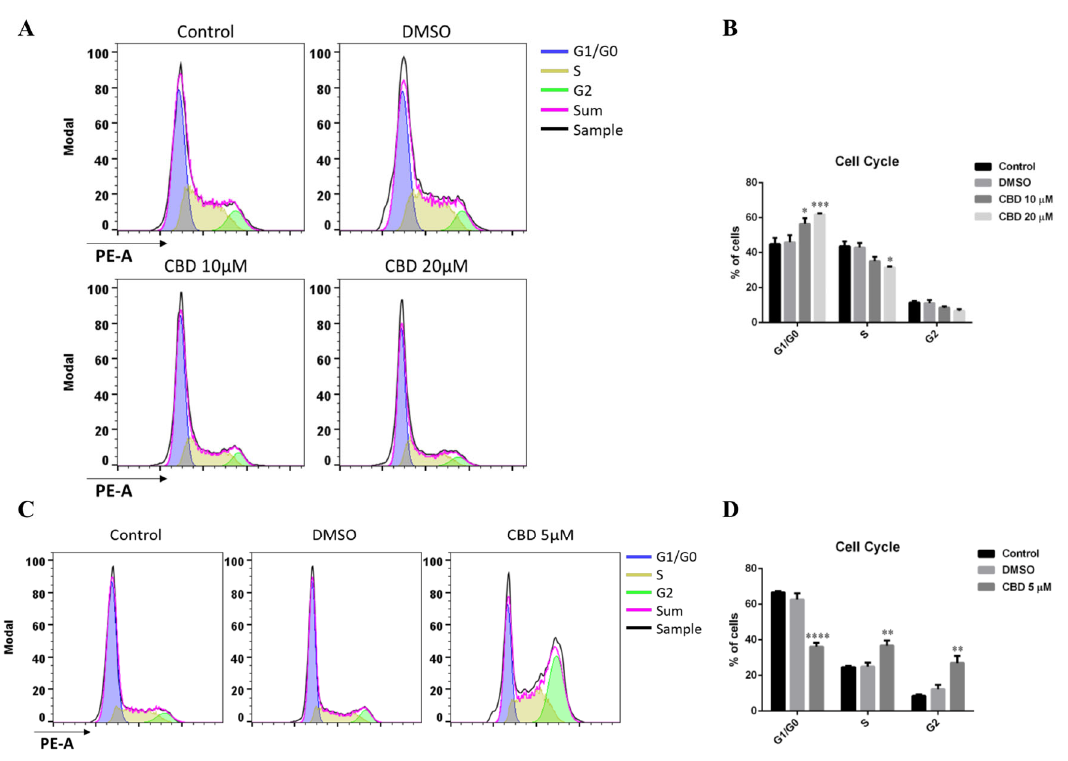
Figure 3. CBD induces cell cycle arrest. ( A , B ) MDA-MB-231 cells were cultured using DMEM supplemented with 10% FBS. 24 h later, cells were treated with 10 or 20 µ M of CBD. After 48 h, cells were collected and used for flow cytometry assay. ( A ) Representative histograms of gated cells in G1/G0 (blue), S (gold), and G2 (green) phases. Plots and analyses were made using FlowJo 10 software. ( B ) Quantitative analyses of distributions or proportions of the cells in each phase. ( C , D ) MDA-MB-231 cells were cultured using DMEM supplemented with 0.5% FBS. Then 24 h later, cells were treated with 5 µ M of CBD. After 48 h, cells were treated as described in ( A , B ). ( C ) Representative histograms of gated cells in G1/G0 (blue), S (gold), and G2 (green) phases. Plots and analyses were made using FlowJo 10 software. ( D ) Quantitative analyses of distributions or proportions of the cells in each phase. Each bar represents the mean ± S.E.M. of data from at least three independent experiments. Differences among groups were analyzed performing a two- way ANOVA followed by Tukey’s multiple comparison test. * p < 0.05, ** p < 0.01, *** p < 0.001, **** p < 0.0001 indicates significance compared to DMSO.